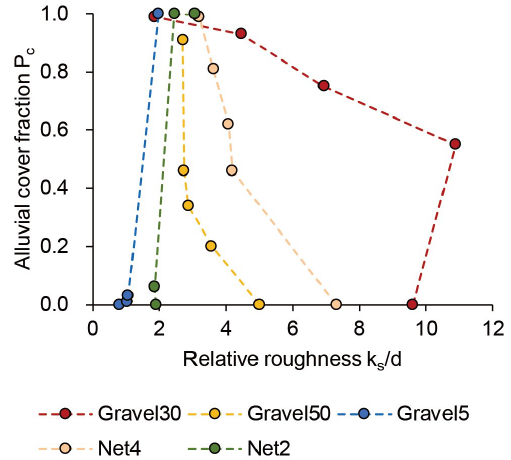
Figure 7. Variations in P c with relative roughness.